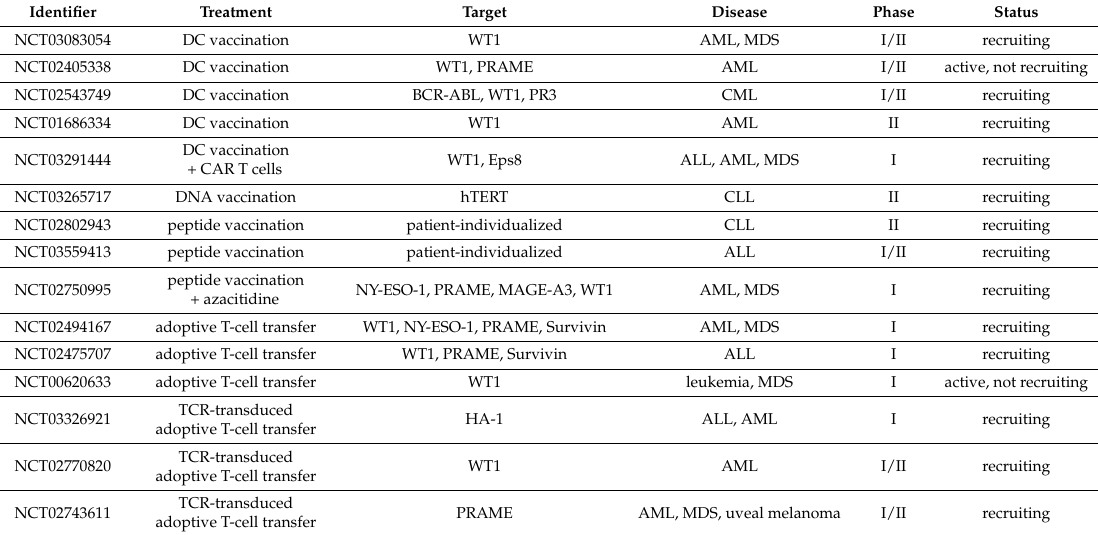
Table 1. Current clinical trials focusing on HLA-dependent immunotherapy in